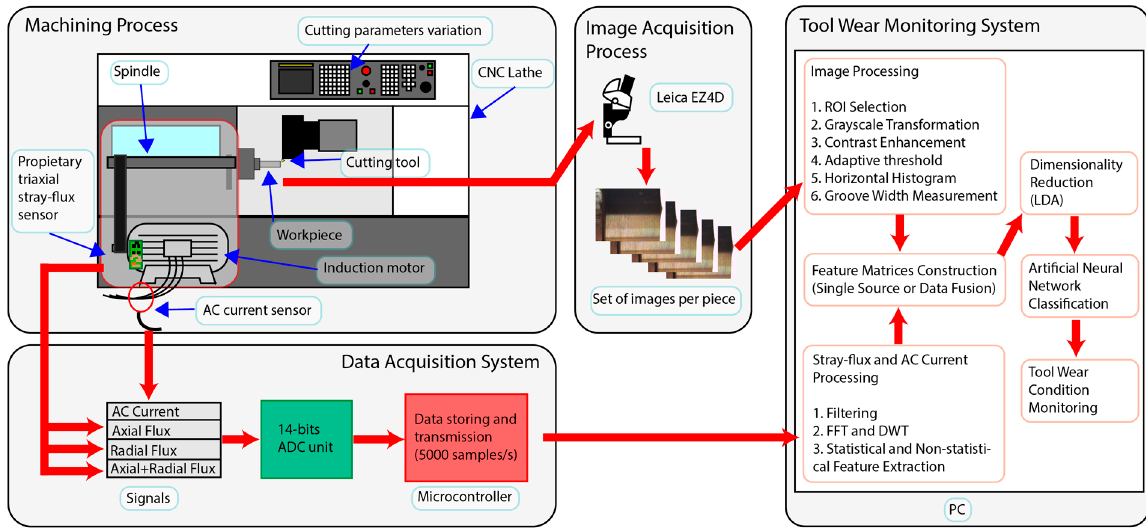
Figure 5. Block diagram for the proposed methodology.